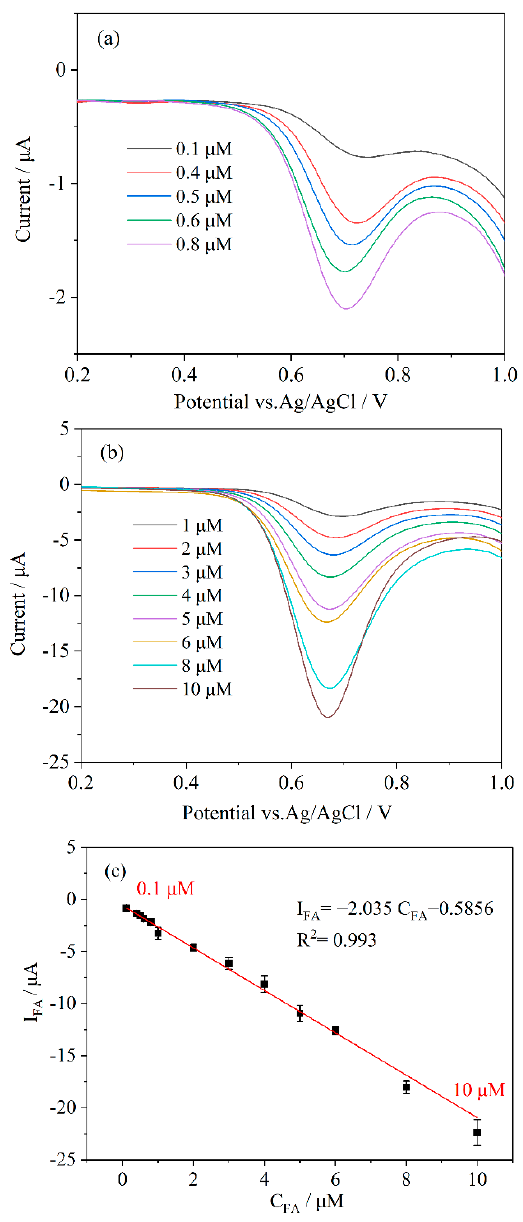
Figure 4. ( a , b ) SWV curves of the ZIF − 67/AgNWs@SPCE sensing platform with different concentra- tions of FA. ( c ) Linear relationship between I FA and C FA from 0.1 μ M to 10 μ M.